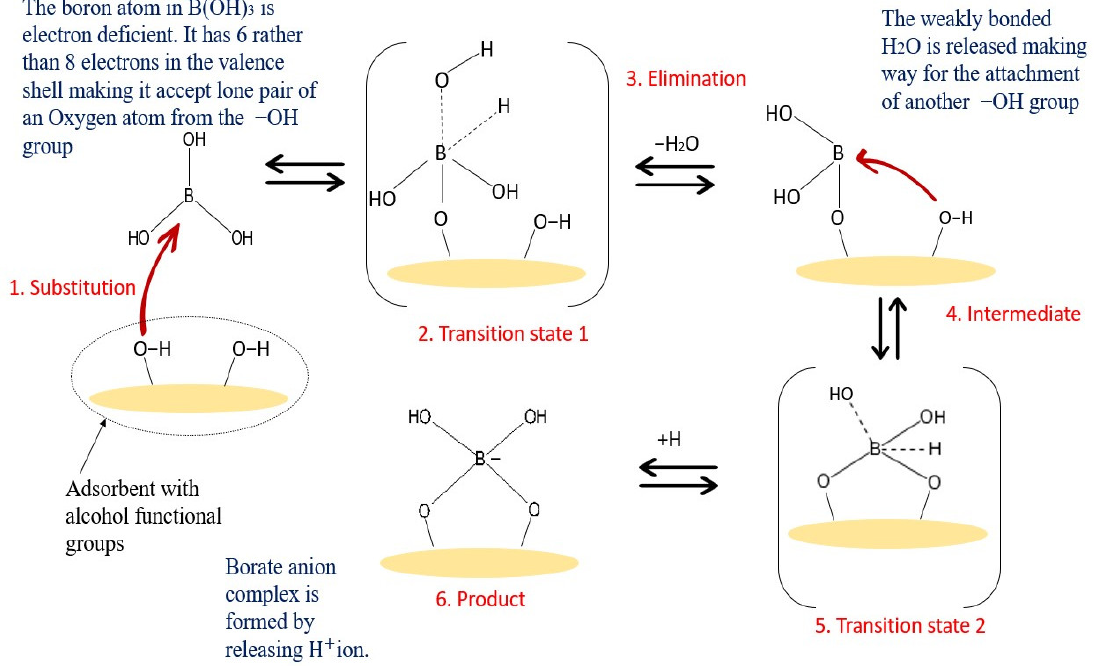
Figure 7. Possible binding mechanism of boric acid and adsorbent with -OH functional groups.